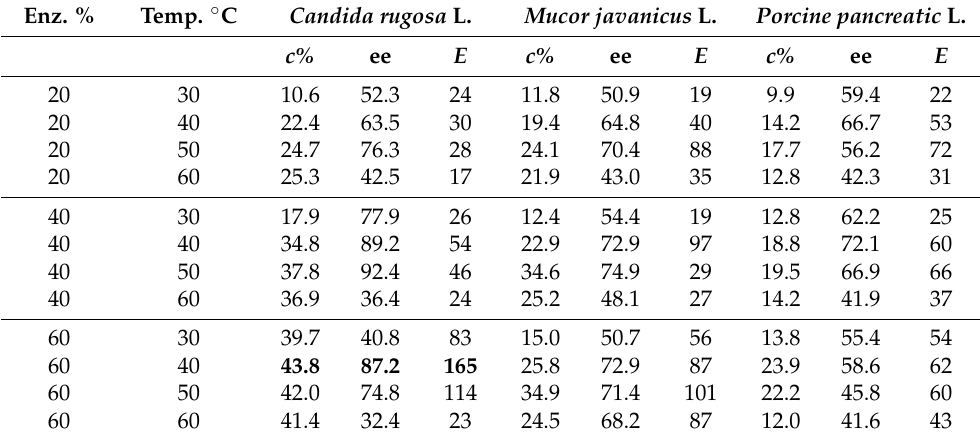
Table 1. Lipase-catalyzed enantioselective esterification of racemic ketoprofen.